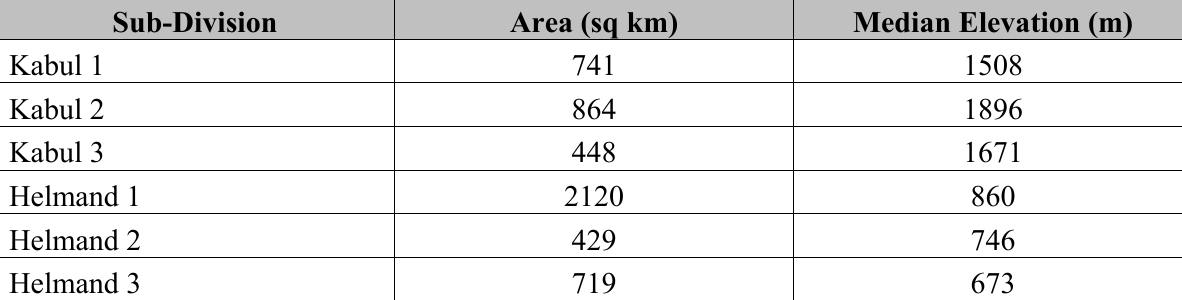
Table 1. Study area characteristics by irrigation area